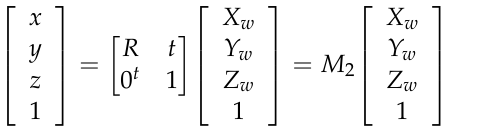
Figure 3. Flow chart of the experiment.